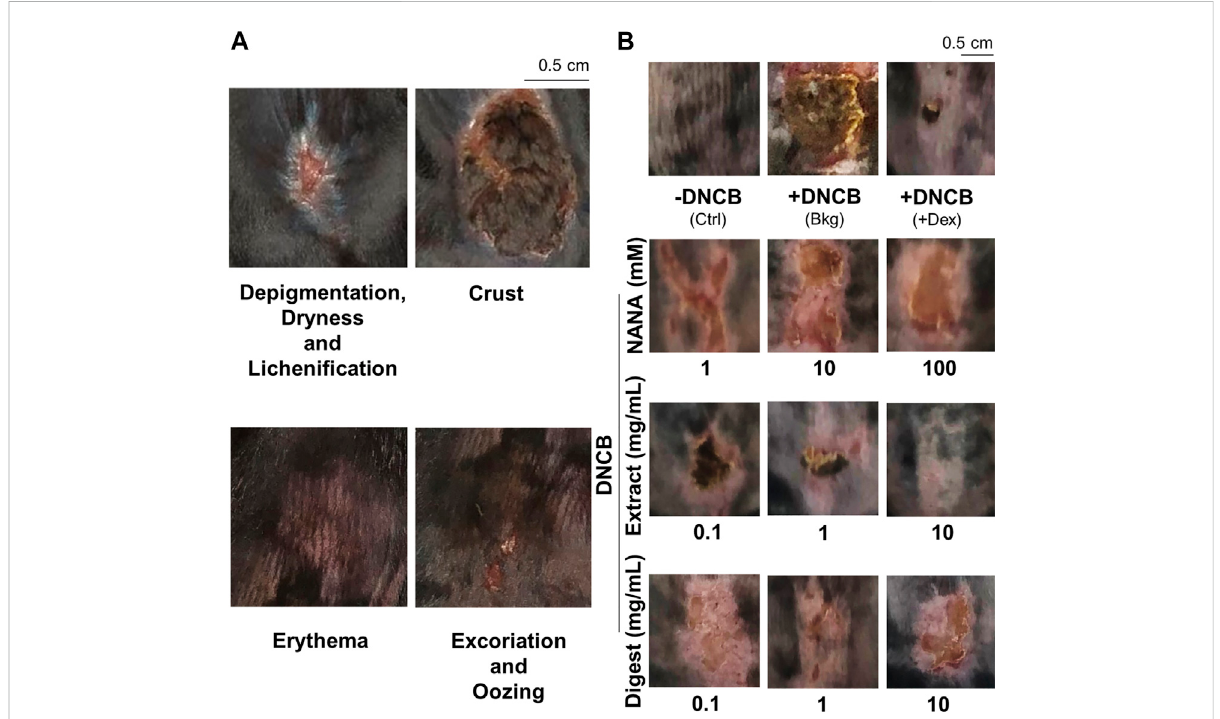
FIGURE 8 EBN lowers intensity of symptoms in DNCB-induced atopic dermatitis mice. The treatment of mice skin was followed as in Figure 7A. (A) Representative images of skin features in DNCB-induced atopic dermatitis mice are shown. (B) Representative images of mice under different treatments at day 11 are